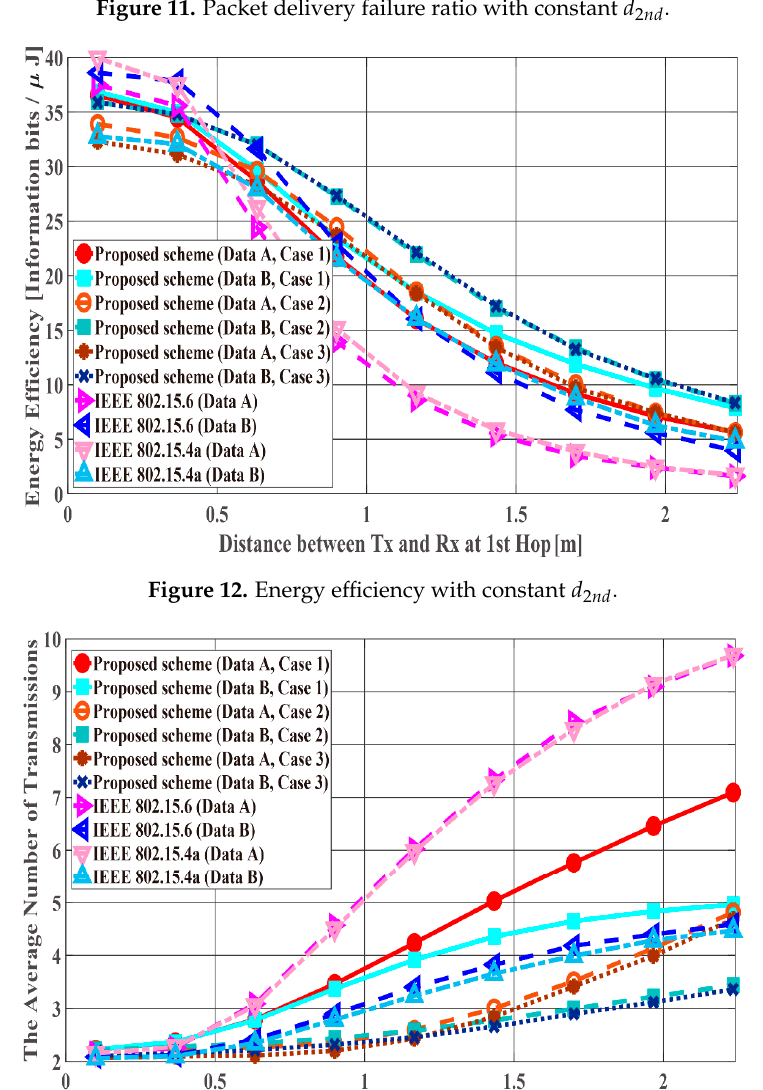
2 nd . Sensors 2018 , 18 , x FOR PEER REVIEW